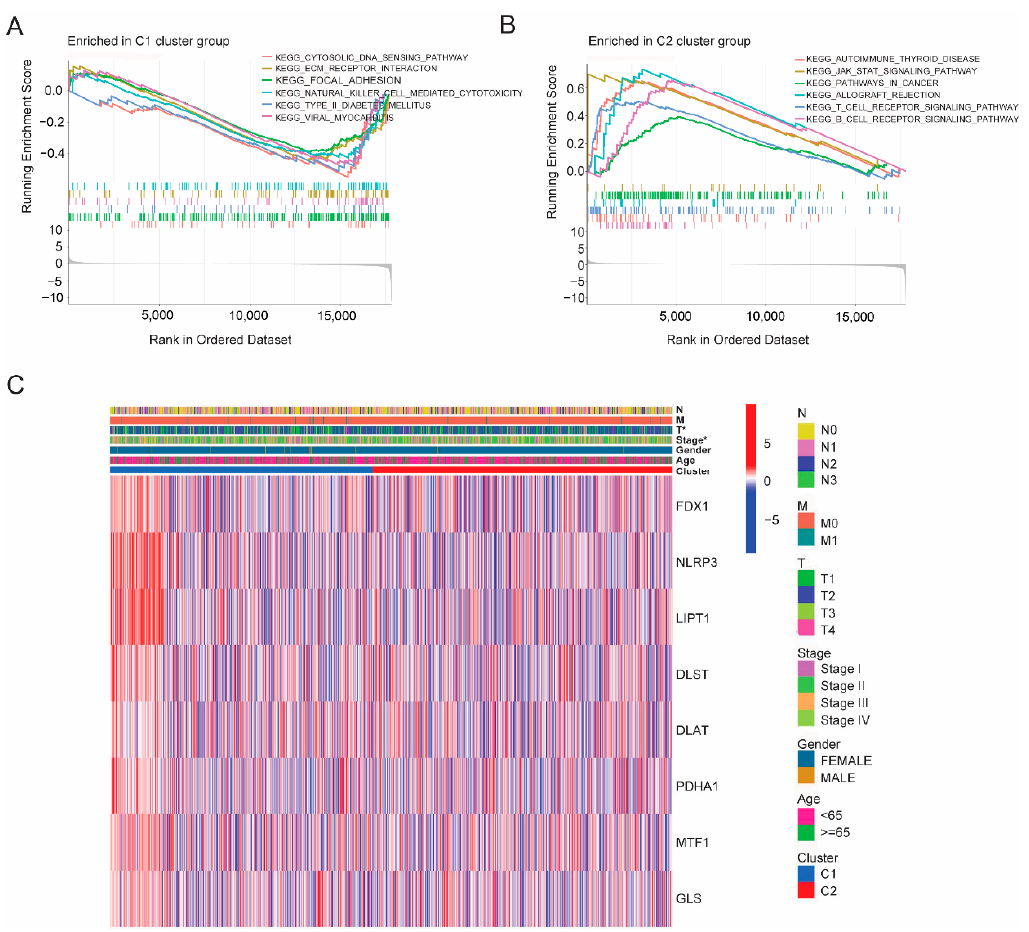
Figure 3. GSEA and the cuproptosis ‐ related DEGs based on the breast cancer clusters. ( A ) GSEA analysis of DEGs based on cluster group 1 (C1). ( B ) GSEA analysis of DEGs based on cluster group 2 (C2). ( C ) A heatmap of cuproptosis ‐ related DEGs based on the breast cancer clusters.